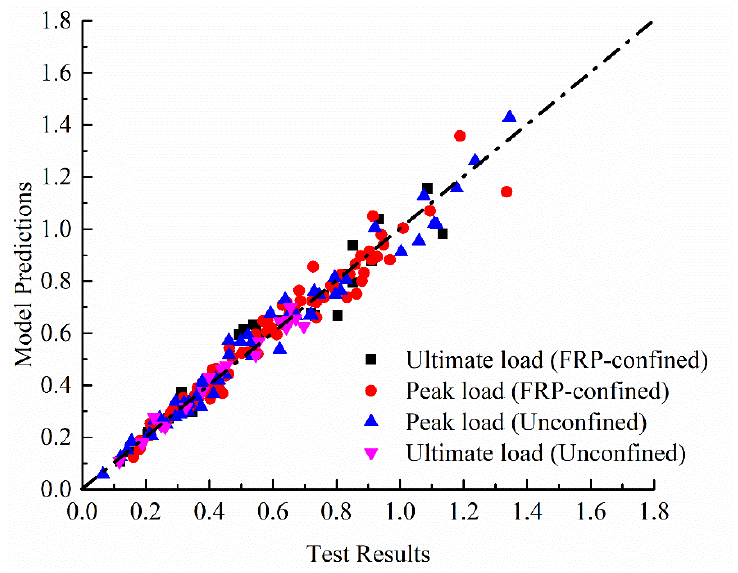
Figure 17. Proposed trends considering a negative effect of increasing eccentricity for columns with FRP hoop only or lateral and longitudinal FRP reinforcement.